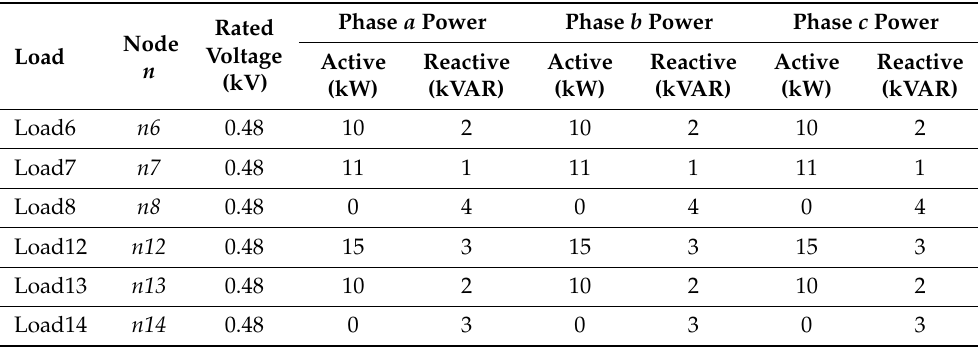
Table A3. Rated voltage and per phase complex power of the system